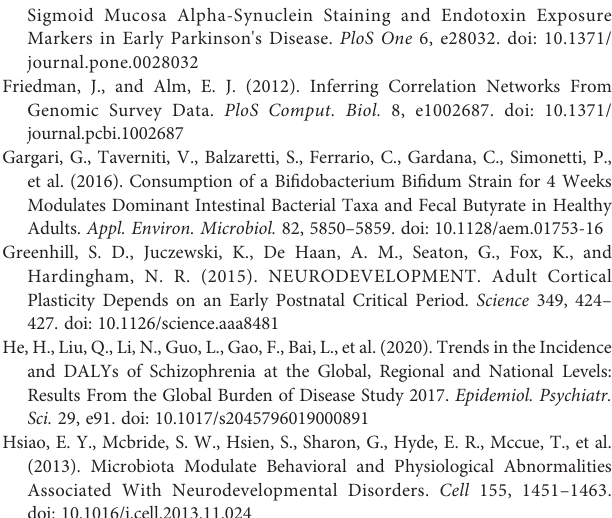
Supplementary Figure 1 | Variations in the compositions of fecal microbiota in the elderly SZ patients and the healthy controls in the phylum, class, order, family, and genus levels. Supplementary Figure 2 | Krona charts showing the fecal microbiota in elderly SZ patients and healthy controls. These taxa represent the internal core microbiota at the individual